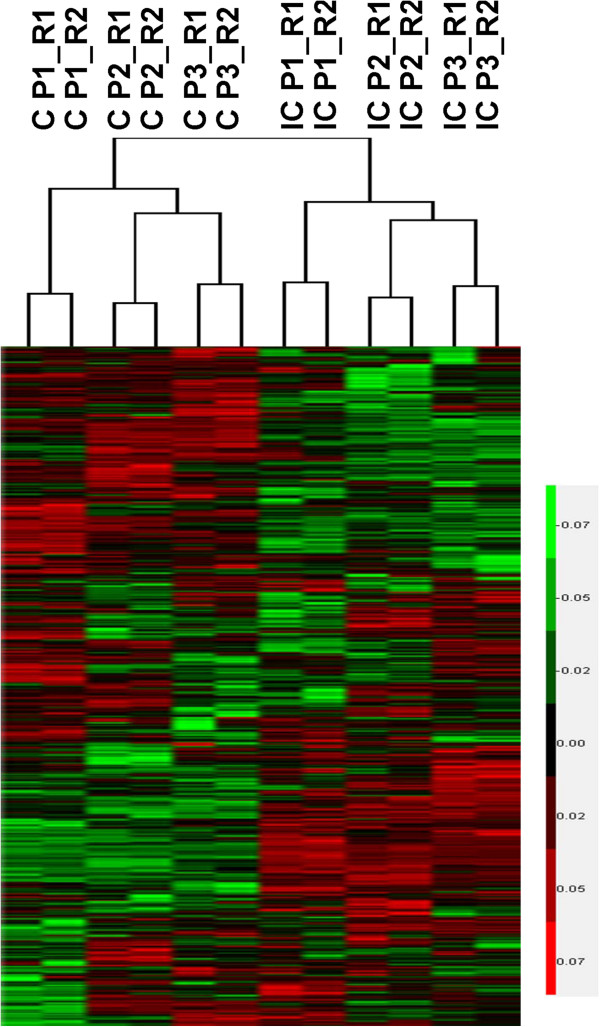
Hierarchical cluster analysis of all the proteins identified in different areas, biological replicates and technical replicates.